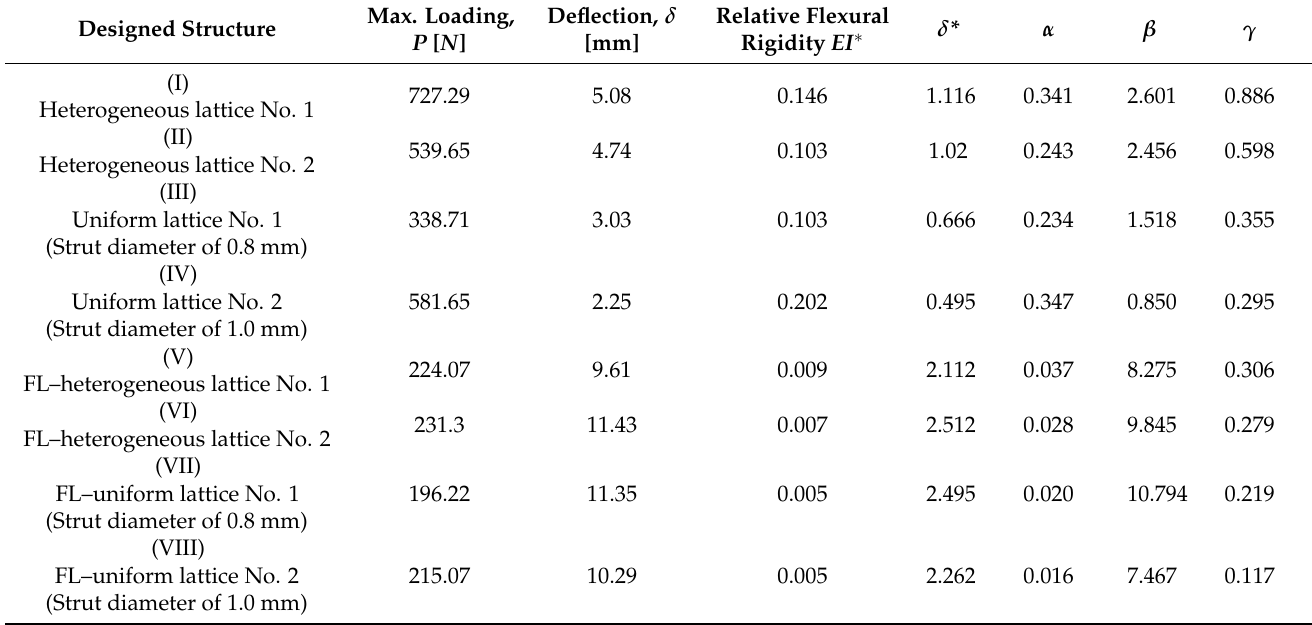
Table 2. Mechanical properties of the designed